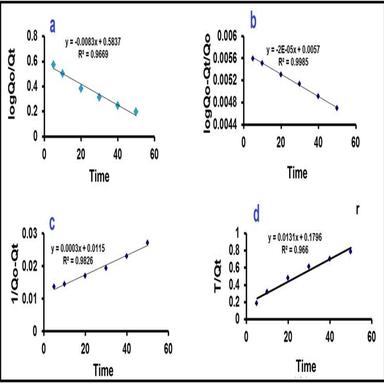
(a) First order, (b) Pseudo-second order (c) second order (d) Pseudo-second order kinetic model for the adsorption of Hg (II) by the adsorbent.